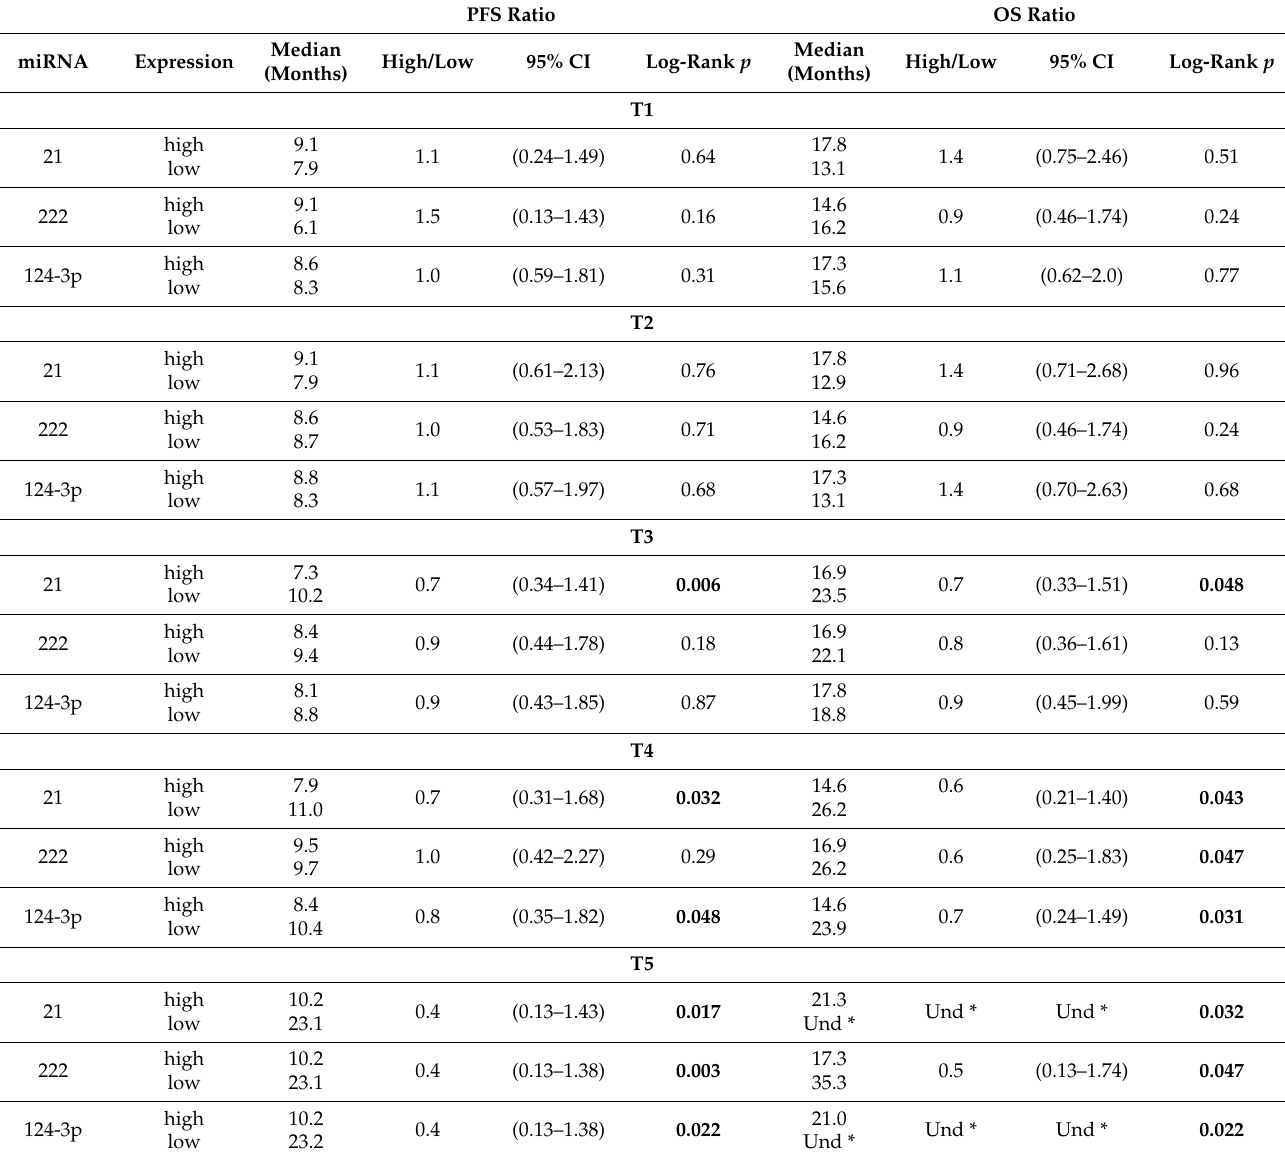
Table 2. Kaplan–Meier